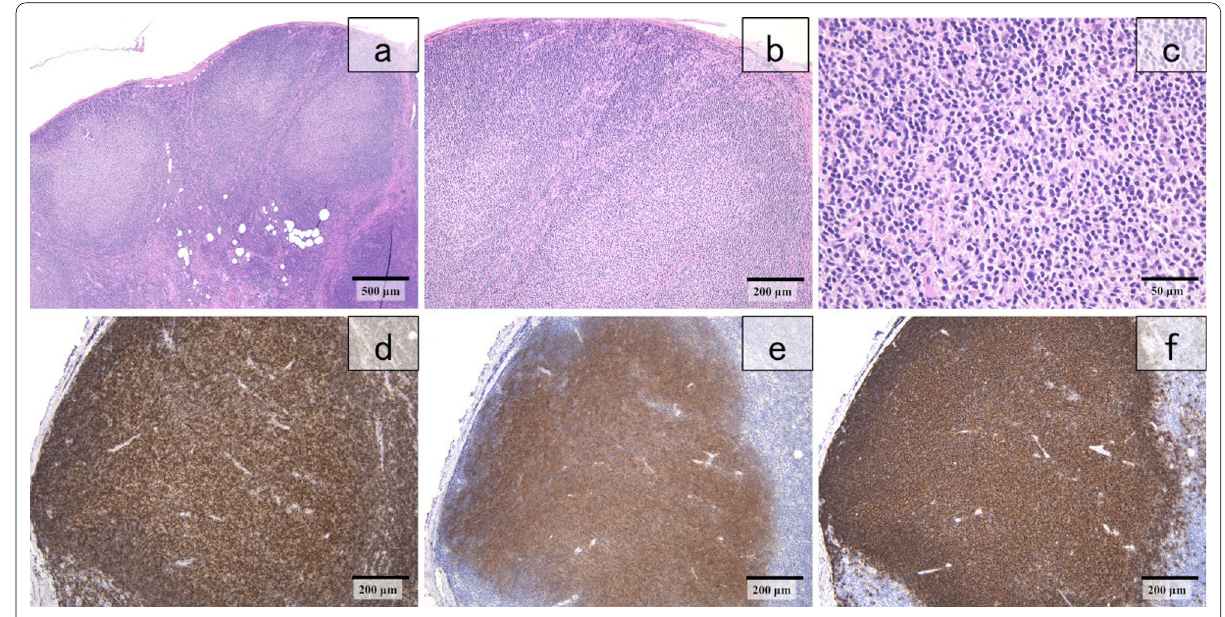
Fig. 6 Histopathological findings of sentinel lymph node. a – c Nodular proliferation of follicular lymphoma (hematoxylin–eosin stain; magnification 4, 100, 400). Immunostained lymphoma cells are d CD20 + , e CD10 + , and f BCL-2 + . Magnification, × × ×